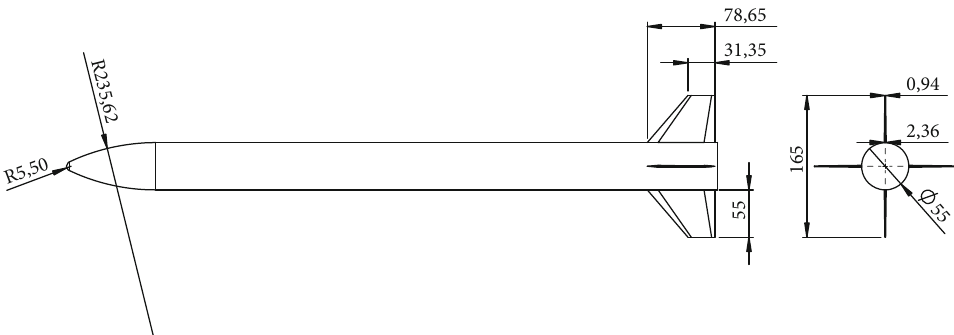
Figure 1: N1G missile con fi guration (all dimensions in mm).